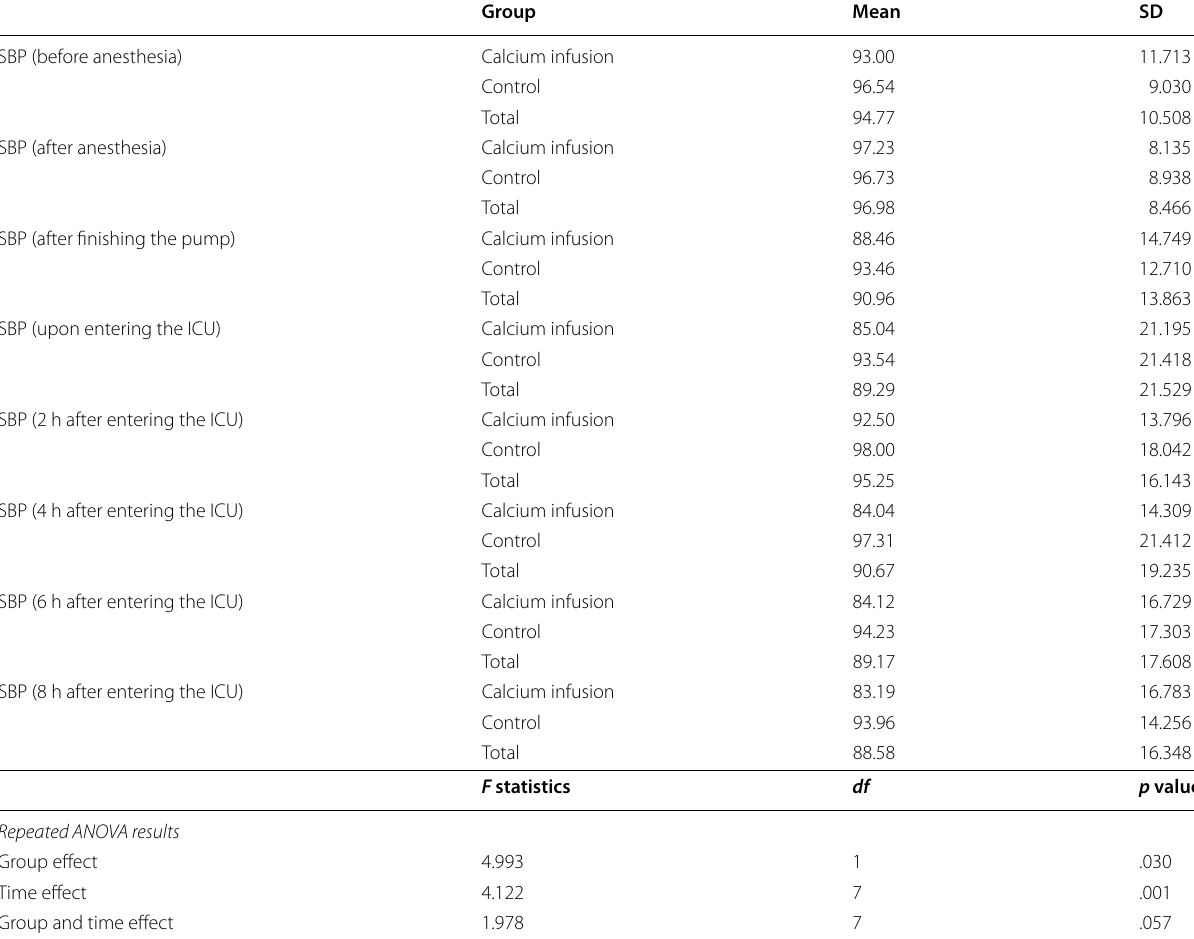
Table 3 Statistics of systolic blood pressure Group Mean